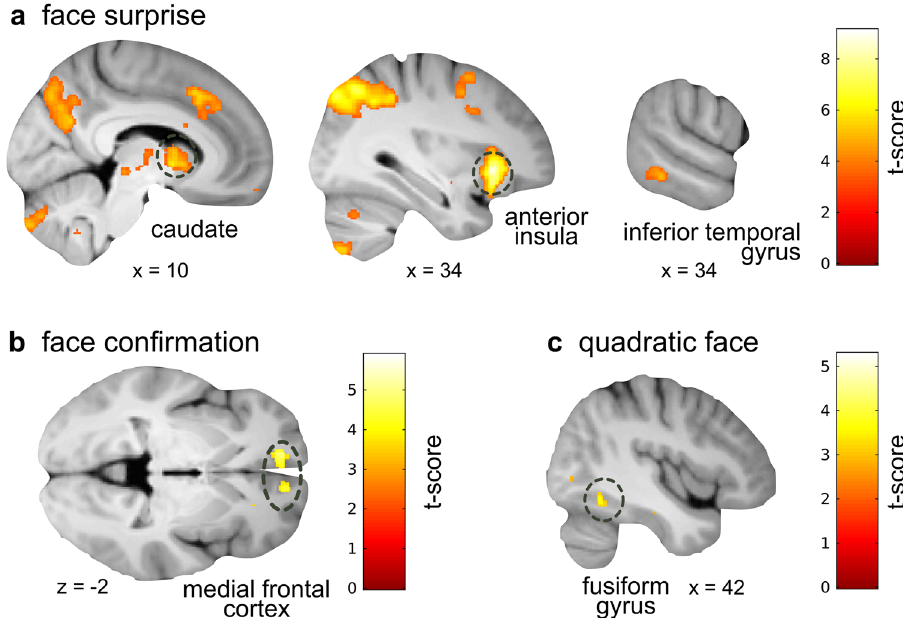
Fig. 3 Univariate fMRI responses to presented face images depending on how much they were expected. a Activity in a typical network related to surprise (e.g., including the insula, caudate, inferior parietal lobe, and a cluster in the inferior temporal gyrus) increased with face surprise (negative linear parametric modulator, shown at p < 0.001, uncorrected). b Face con fi rmation, i.e., more expected faces, lead to stronger responses in the medial frontal cortex (positive linear parametric modulator). c U-shape response to faces re fl ecting increased activity for highly expected and unexpected faces was identi fi ed in the fusiform gyrus (quadratic parametric